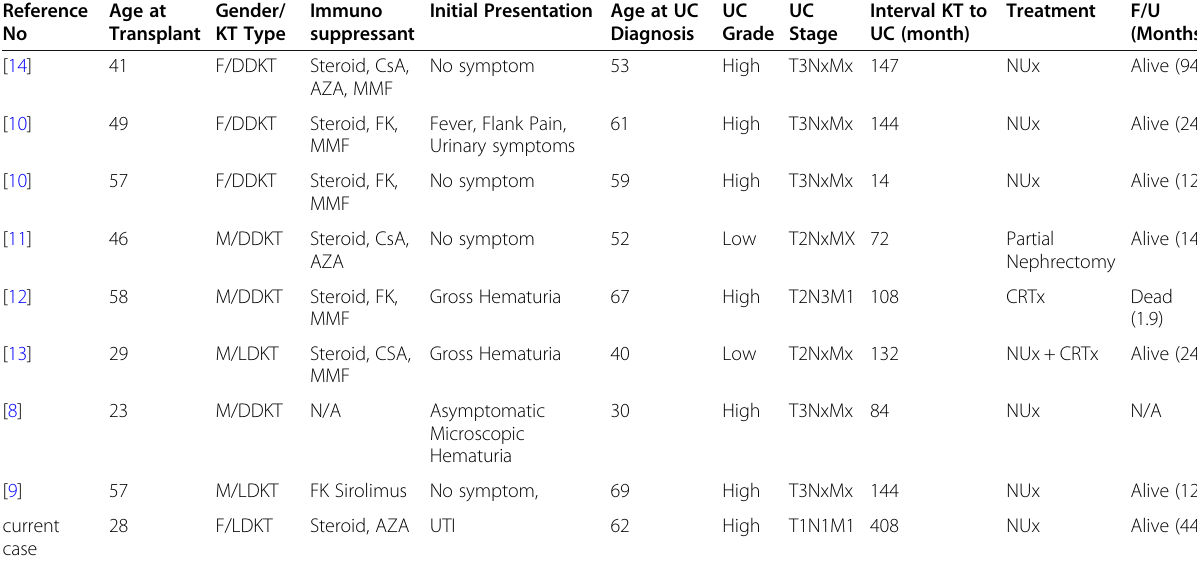
Table 2 Clinicopathological Characteristics of Urothelial Carcinoma in Graft Kidney Reference Age at Gender/ Immuno Initial Presentation Age at UC No Transplant KT Type suppressant